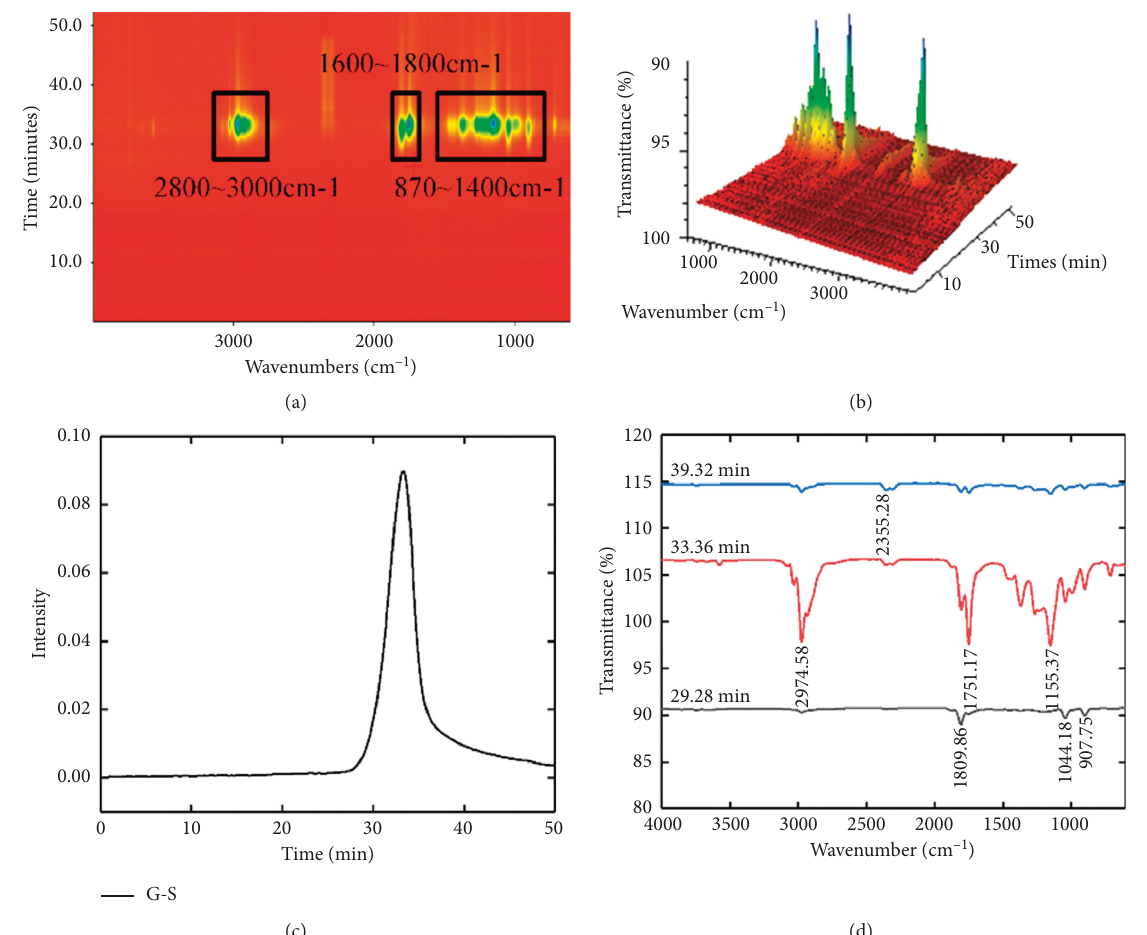
Figure 9: Dynamic-FTIR analysis results of T662. (a) 2D. (b) 3D. (c) GS. (d)